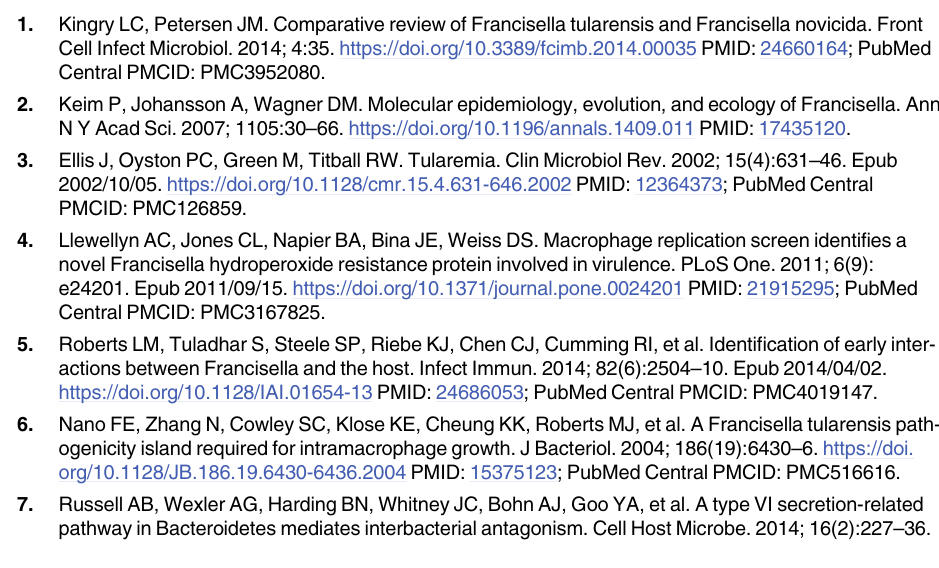
S1 Table. Classification of genes based on EL-ARTIST analysis of F . tularensis LVS Tn-Seq library mutants grown in vitro . S2 Table. Genes identified as important for intramacrophage growth of F . tularensis LVS using Con-ARTIST